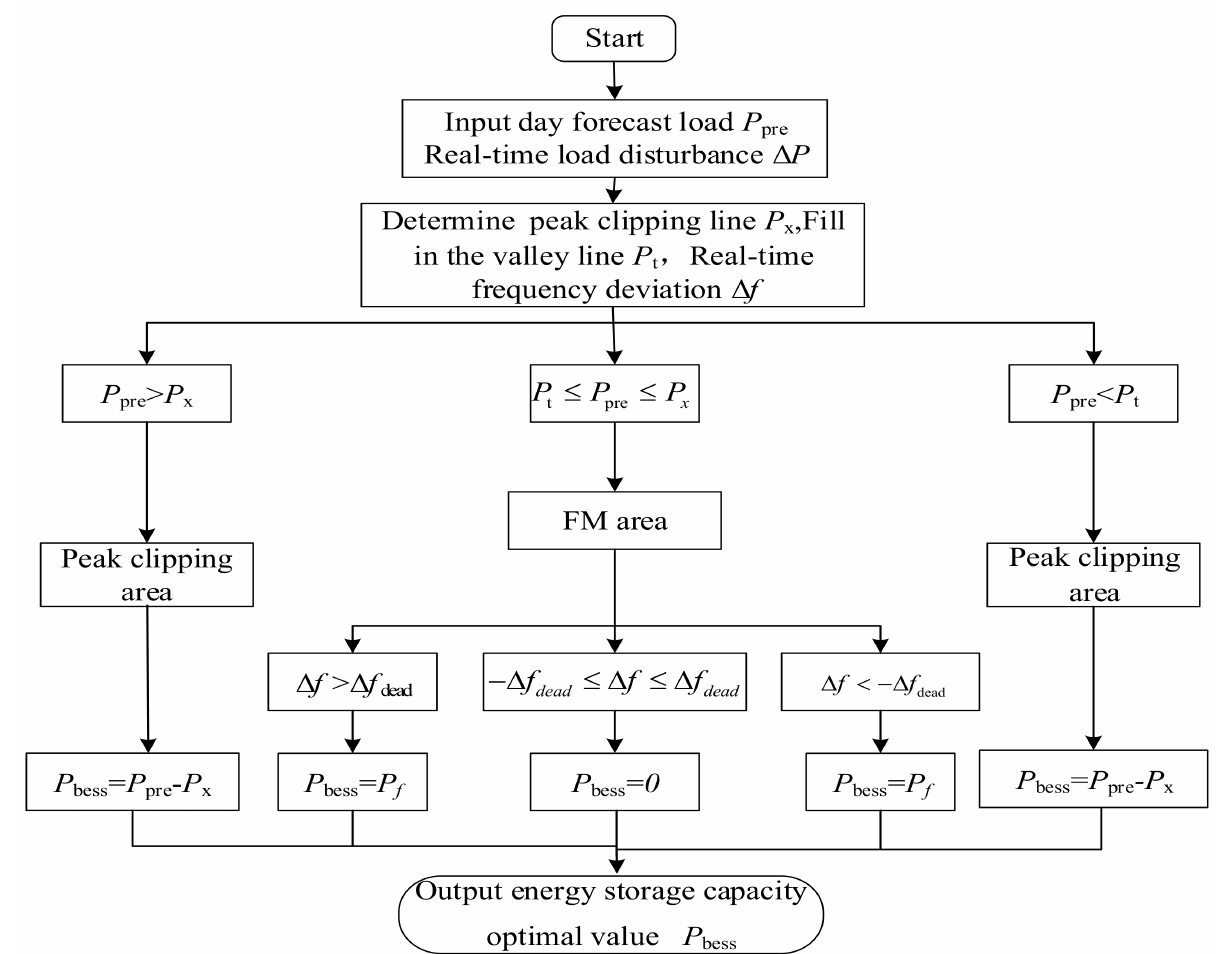
Figure 4. Control policy coordination flow in multiple